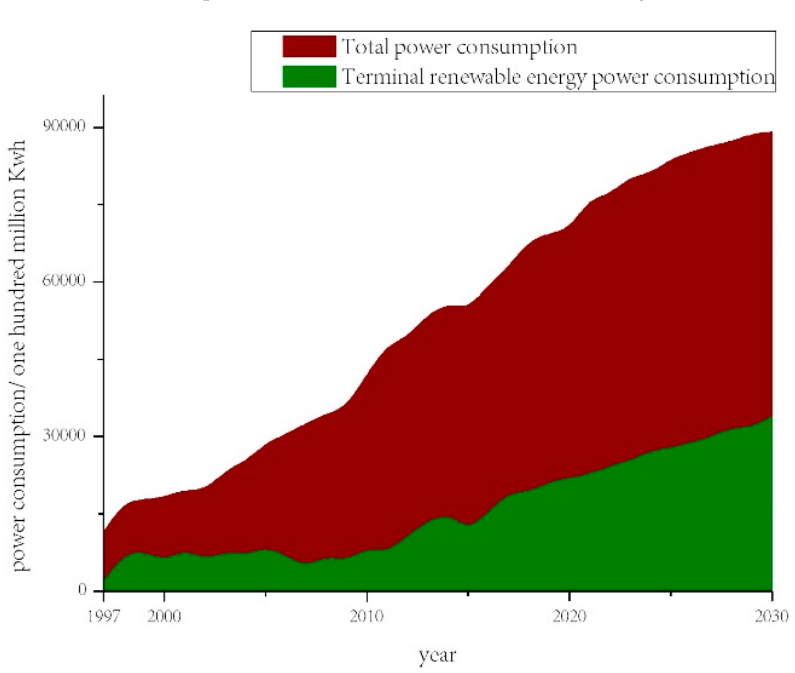
Figure 8. Output result of the EMD-BFO-IELM forecasting model.